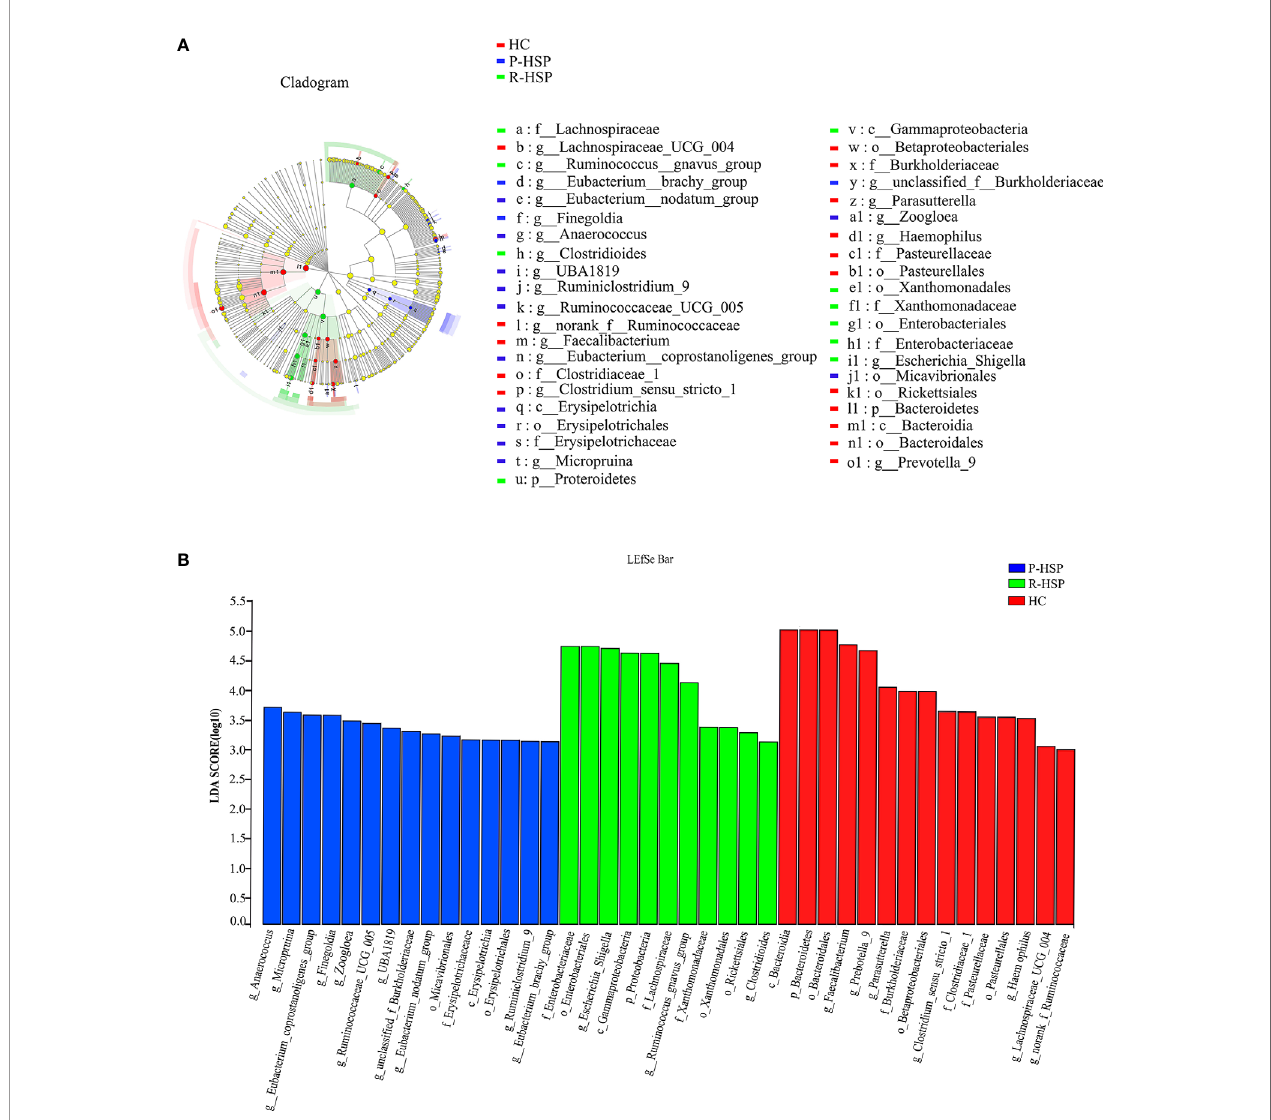
FIGURE 4 | Differentially abundant bacterial taxa associated with patients with HSP and healthy controls according to LEfSe analysis. (A) Cladogram showing the phylogenetic distribution of the bacterial lineages in the three groups. The phylum, class, order, family, and genus levels are listed in order from the inside to the outside of the cladogram, and different-colored regions represent different constituents: healthy control group is shown in red, primary HSP in blue, and recurrent HSP in green, whereas the yellow circles represent taxa with no signi fi cant differences between the three groups. The picture shows that Bacteroidetes (from phylum to genus) are prominent in the healthy control group, Proteroidetes (from phylum to genus) are signi fi cantly enriched in the recurrent HSP group, and Erysipelotrichia (from class to genus) are enriched in the primary HSP group. (B) Horizontal bars represent the effect size for each taxon. The length of the bar represents the log10 transformed LDA score as indicated by vertical dotted lines. The threshold on the logarithmic LDA score for discriminative features is set to 4.0. LDA scores show signi fi cant bacterial differences between the three groups. The healthy control group is characterized by a preponderance of Faecalibacterium and Prevotella_9 (LDA score [log10] > 4.5) and recurrent HSP is characterized by a preponderance of Escherichia-Shigella (LDA score [log10] > 4.5). p, phylum; c, class; o, order; f, family; g,